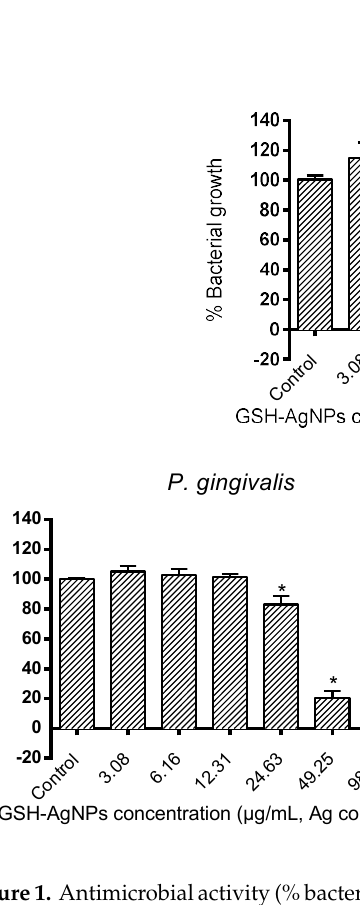
Figure 1. Antimicrobial activity (% bacteria growth respect to the control) of glutathione-stabilized silver nanoparticles (GSH-AgNPs) against Sreptococcus mutans , Porphyromonas gingivalis, and Fusobacterium nucleatum . Results are presented as mean ± standard deviation. * Significant differences respect to the control ( p < 0.01). Table 1. Minimum inhibitory concentration (MIC), Minimum bactericidal concentration (MBC), and the half-maximal inhibitory concentration (IC 50 ) values ( µ g / mL, Ag concentration) of GSH-AgNPs nanoparticles against the oral bacteria